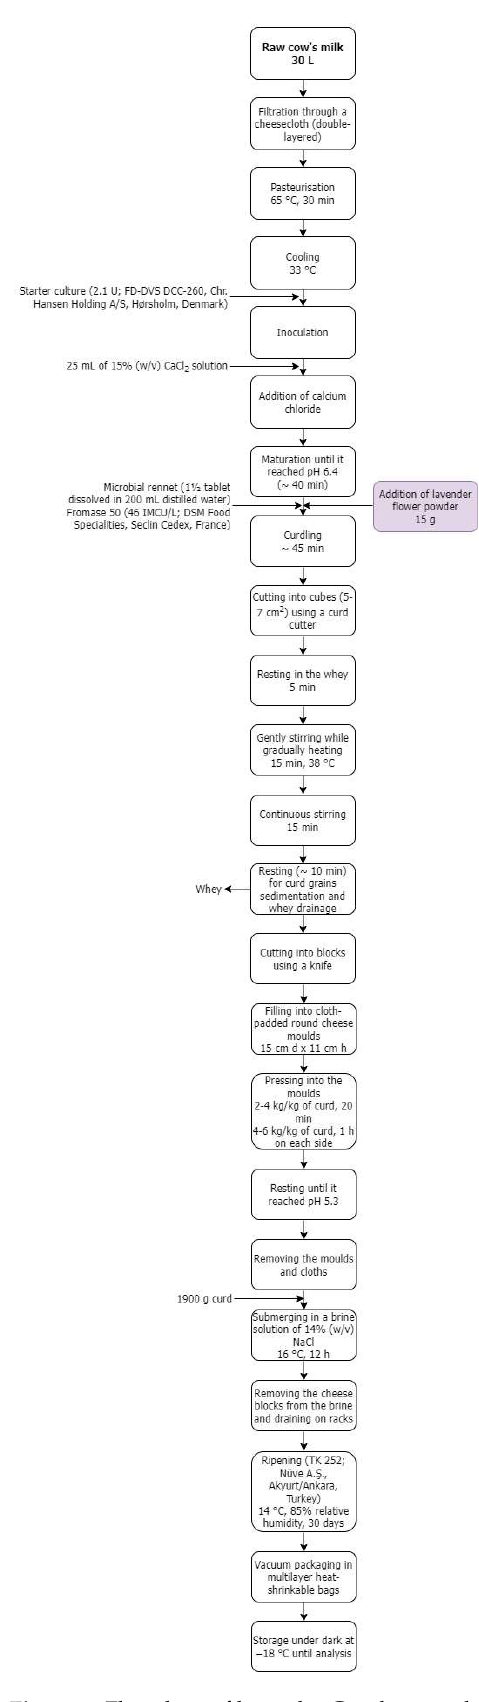
Figure 1. Flowchart of lavender Gouda-type cheese manufacturing process.